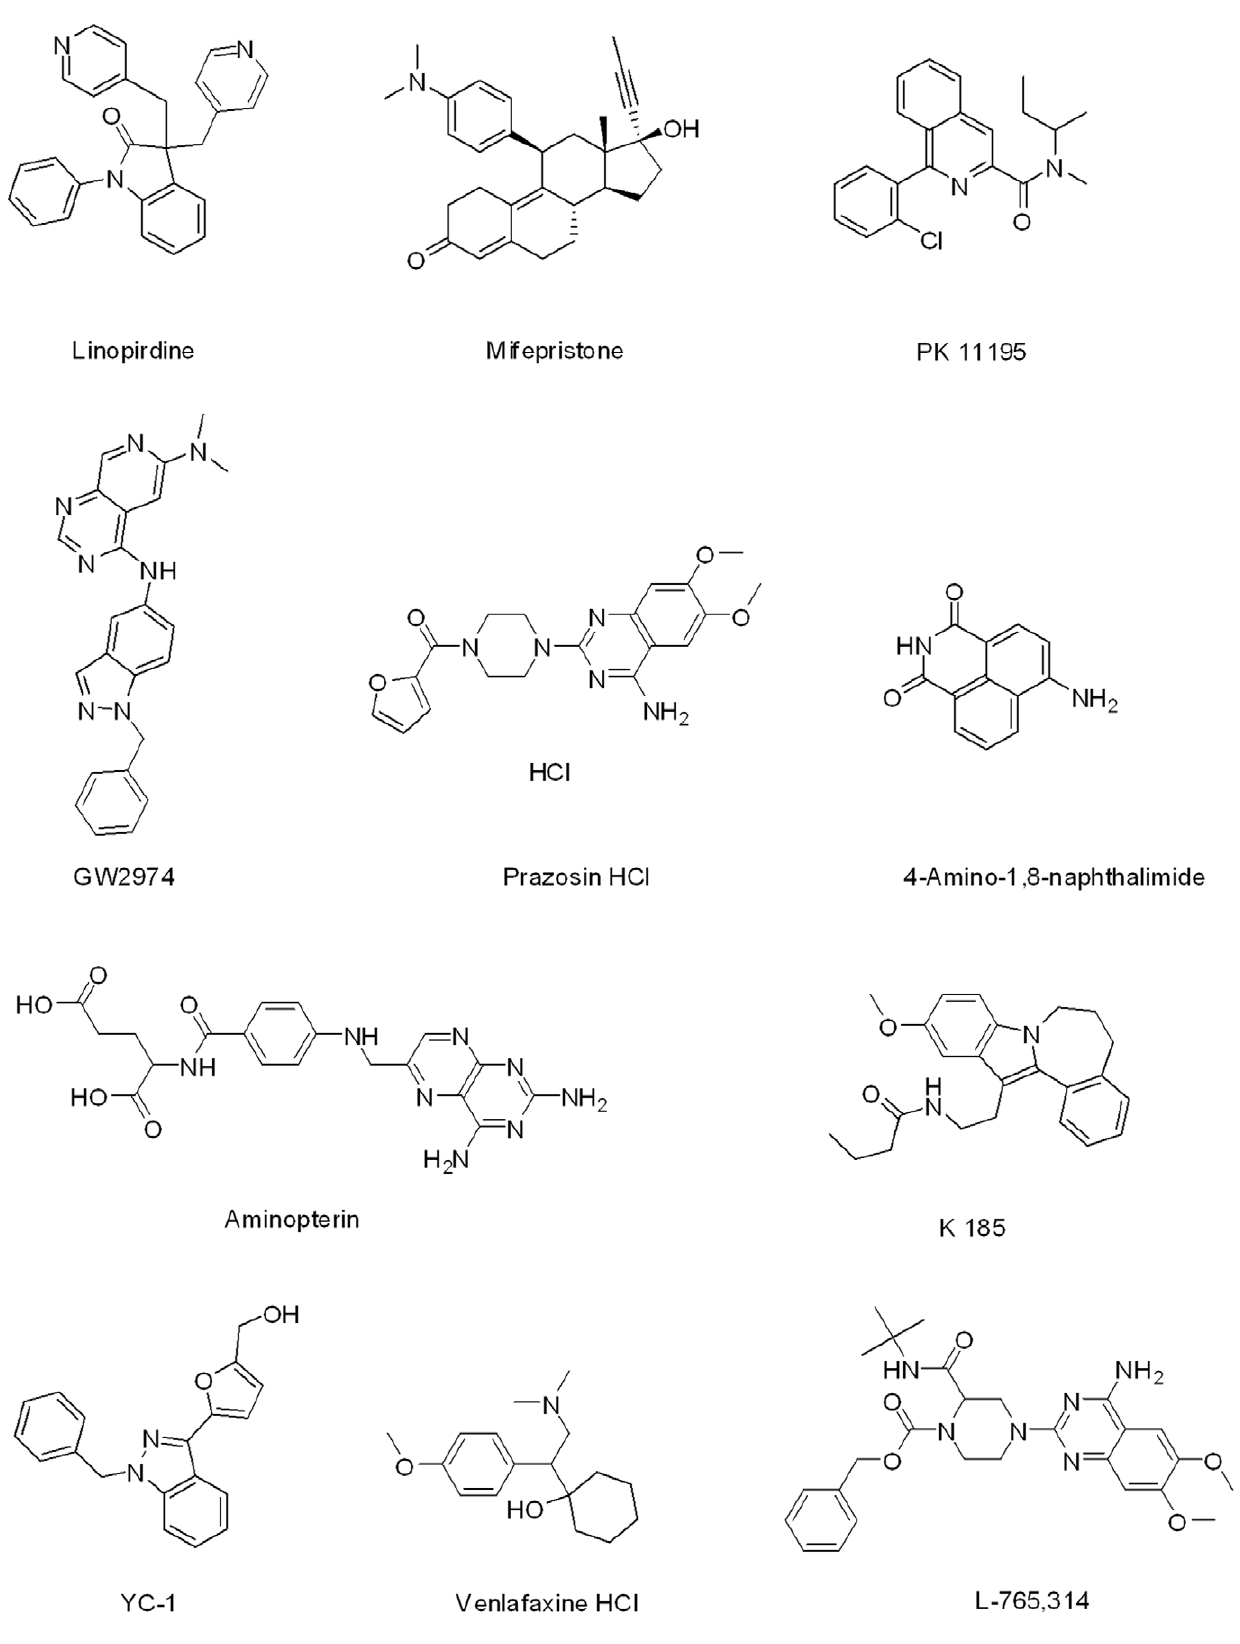
Figure 8. Structures of the top hits from the AGP and HSA LOPAC 1280 Screen.